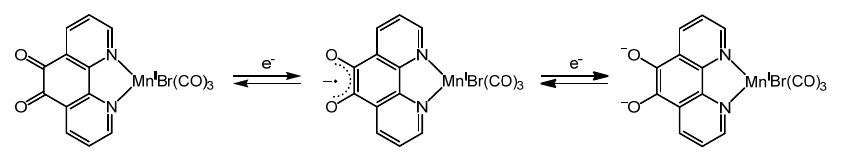
(glassy carbon WE): ( a ) 0 equiv. and ( b ) 2 equiv. of H + ( v = 0.1 V s − 1 ). An aqueous solution of HClO 4 (0.1 M) was used as the proton source.